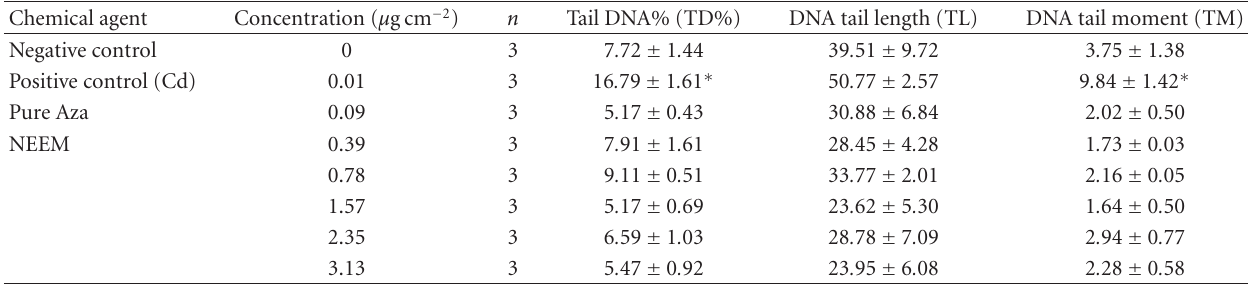
Table 3: Comet assay results in Pheretima peguana coelomocytes following a 48-h exposure to commercial neem extract (NEEM), pure Aza, and Cd in filter